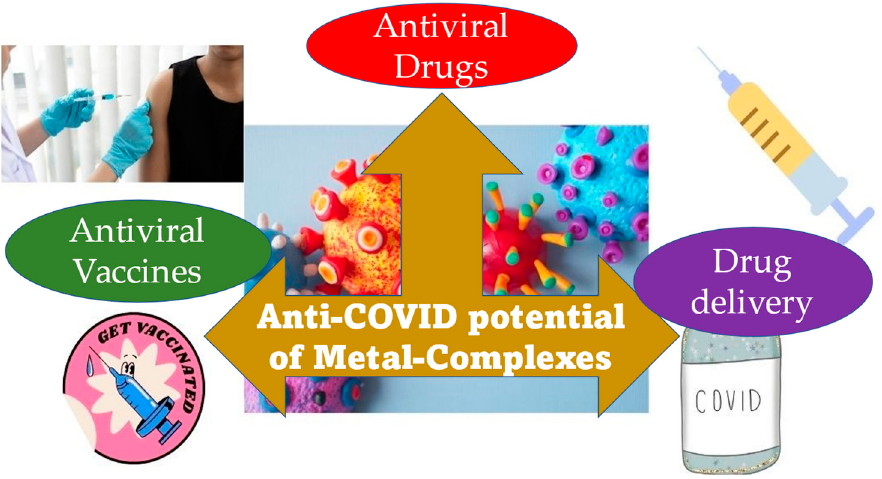
Figure 3. Three modes of contribution from metal complexes towards the anti-COVID-19 activity.